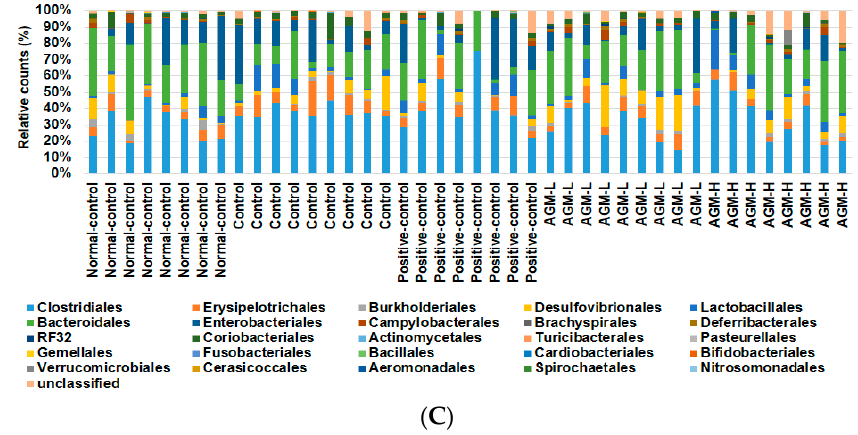
Figure 5. The profiles of gut microbiomes Px rats were fed a high fat diet supplemented with aronia, red ginseng, shiitake mushroom, and nattokinase powders (1) 0.5 g mixture/kg bw/day (AGM-L; n = 8), (2) 1 g mixture/kg bw/day (AGM-H; n = 8), (3) 1 g dextrin/kg bw/day (control; n = 8), or (4) metformin (120 mg/kg body weight; positive-control; n = 8) for 12 weeks. Sham rats were fed the same diet as the control ( n = 8). At the end of experimental periods feces were collected and the bacterial DNA was analyzed. The fecal bacterial community was shown in principal coordinate analysis (PCoA) ( A ). Proportion of taxonomic assignments [Phylum ( B ) and Order ( C )] for gut microbiomes was analyzed.